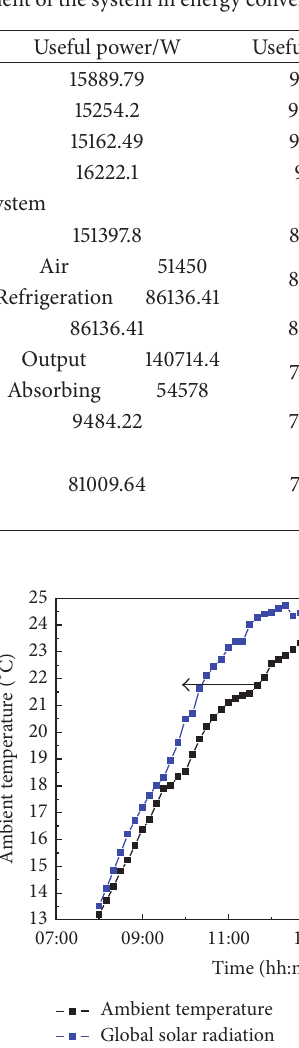
Table 4: Calculated results of total energy and total exergy of each component of the system in energy conversion and transmission process.